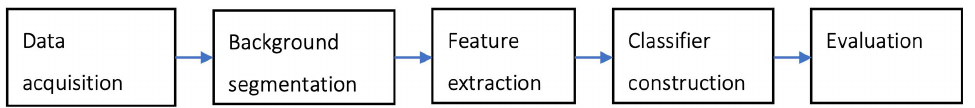
Figure 3. The computer vision framework followed in this work: data acquisition, background segmentation, feature extraction, construction of machine-learning classifiers and